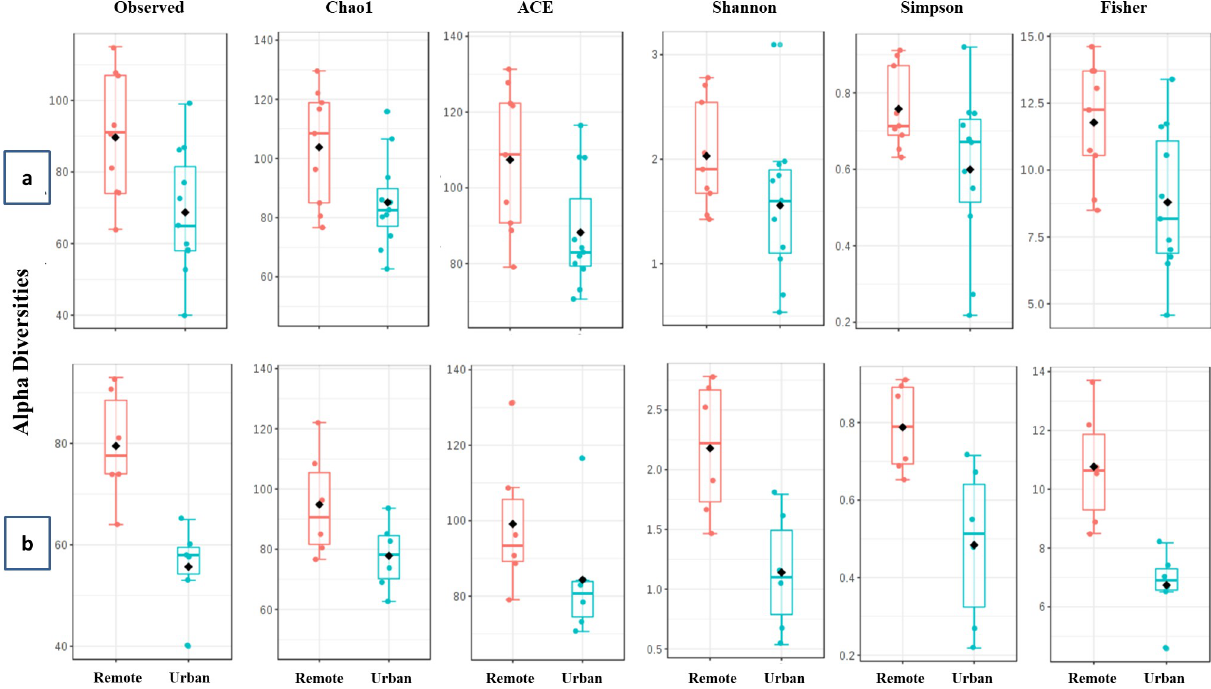
Fig 3. Alpha diversity plots of (a) Bacterial and (b) Fungal communities. Students T-test was employed for comparisons when the experimental factor was sample collection site. Observed alpha diversity estimates are based on unique taxa richness or counts in each sample; Chao1 and ACE diversities are based on low abundance taxa richness; Shannon, Simpson and Fisher estimates are based on both taxa evenness (distribution) as well as richness. https://doi.org/10.1371/journal.pone.0241283.g003 sample grouping. An R-value closer to 1 means the groups are dissimilar, while an R-value near 0 means negligible dissimilarity. In our case both the tests returned an R 2 of 0.18 (P < 0.004) and 0.306 (P < 0.004) suggesting low to moderate diversity among the bacterial communities in all the samples with respect to distribution between sites. Very low but signifi- cant PERMANOVA R 2 (0.096; P < 0.021) and ANOSIM R 2 (0.153; P < 0.014) were recorded for fungal genera as well. As mentioned previously, values approaching 1 are highly different;